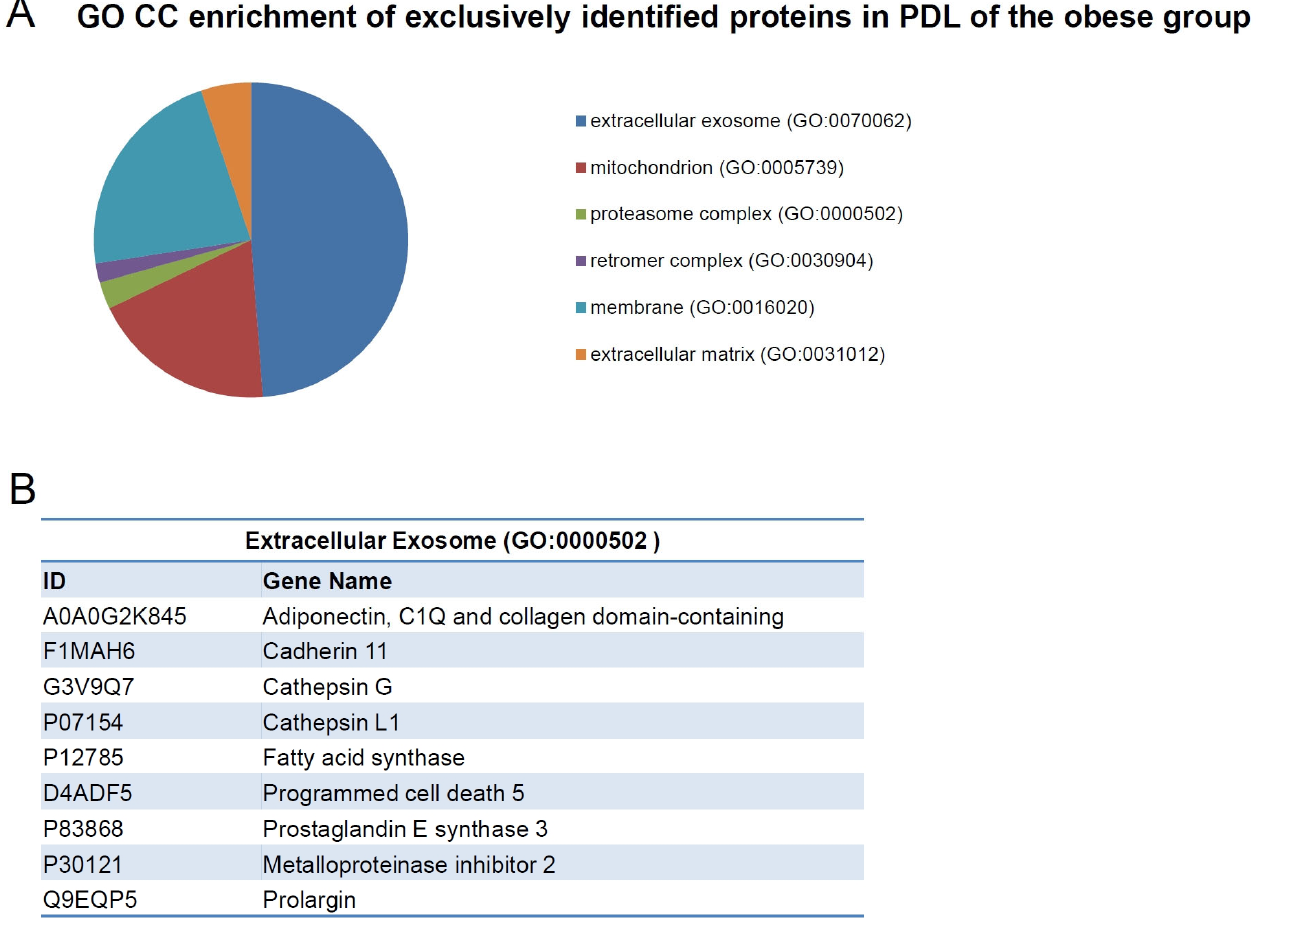
Figure 7. ( A ) Graph containing the GO enrichment analysis of exclusively identified proteins in the PDL of obese animals using DAVID software, which revealed that the proteins were related to the term “cellular component” (CC). ( B ) List of some proteins detected in the GO CC term “extracellular exosome” are highlighted: adiponectin (A0A0G2K845), cadherin 11 (F1MAH6), cathepsin G (G3V9Q7), cathepsin L1 (P07154), fatty acid synthase (P12785), programmed cell death 5 (D4ADF5), prostaglandin E synthase 3 (P83868), metalloproteinase inhibitor 2 (P30121), and prolargin (Q9EQP5).